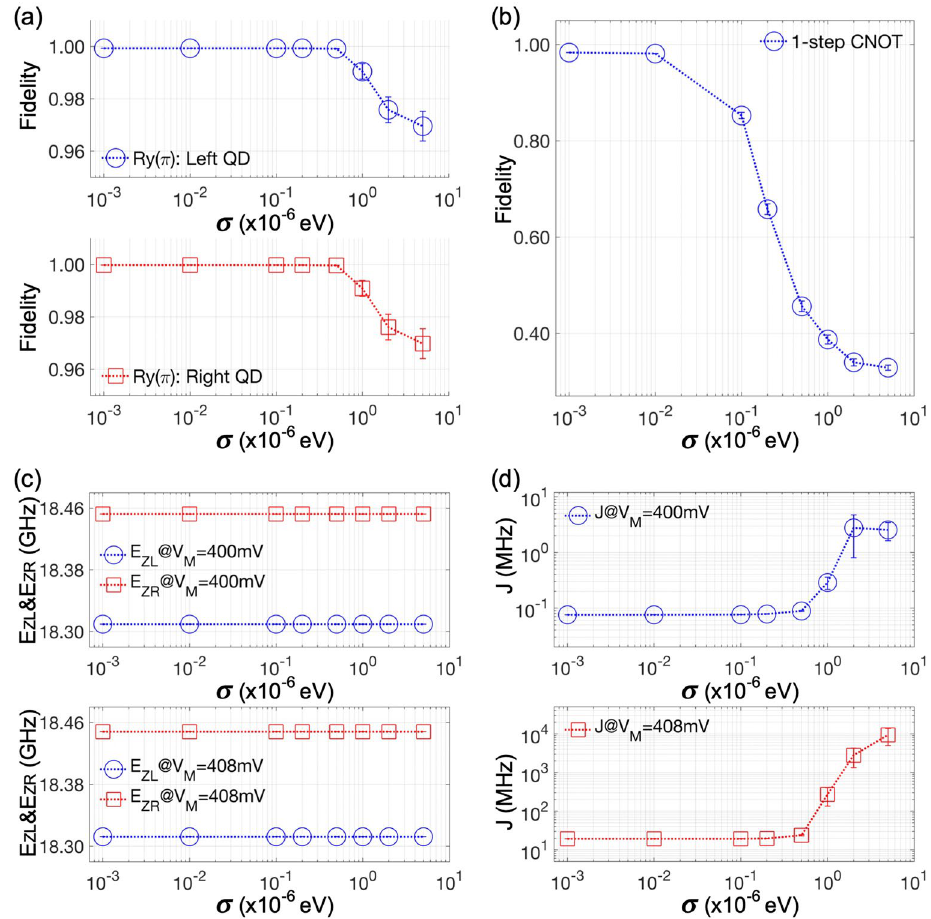
Figure 4. Noise-driven behaviors of 1-qubit rotation and single-step CNOT operation. ( a ) The fidelity of a R Y (π) operation conducted with the left and the right quantum dot (QD) are presented as a function of the magnitude of charge noise ( σ : standard deviation of noisy potential values that are randomly generated per grid of the modeling domain). The fidelity obtained with 1000 samples is 99.93±10 − 3 (right QD) when σ = 10 − µeV, and becomes 96.95±0.5664% and 96.98±0.5687% when σ = 5 µeV. ( b )